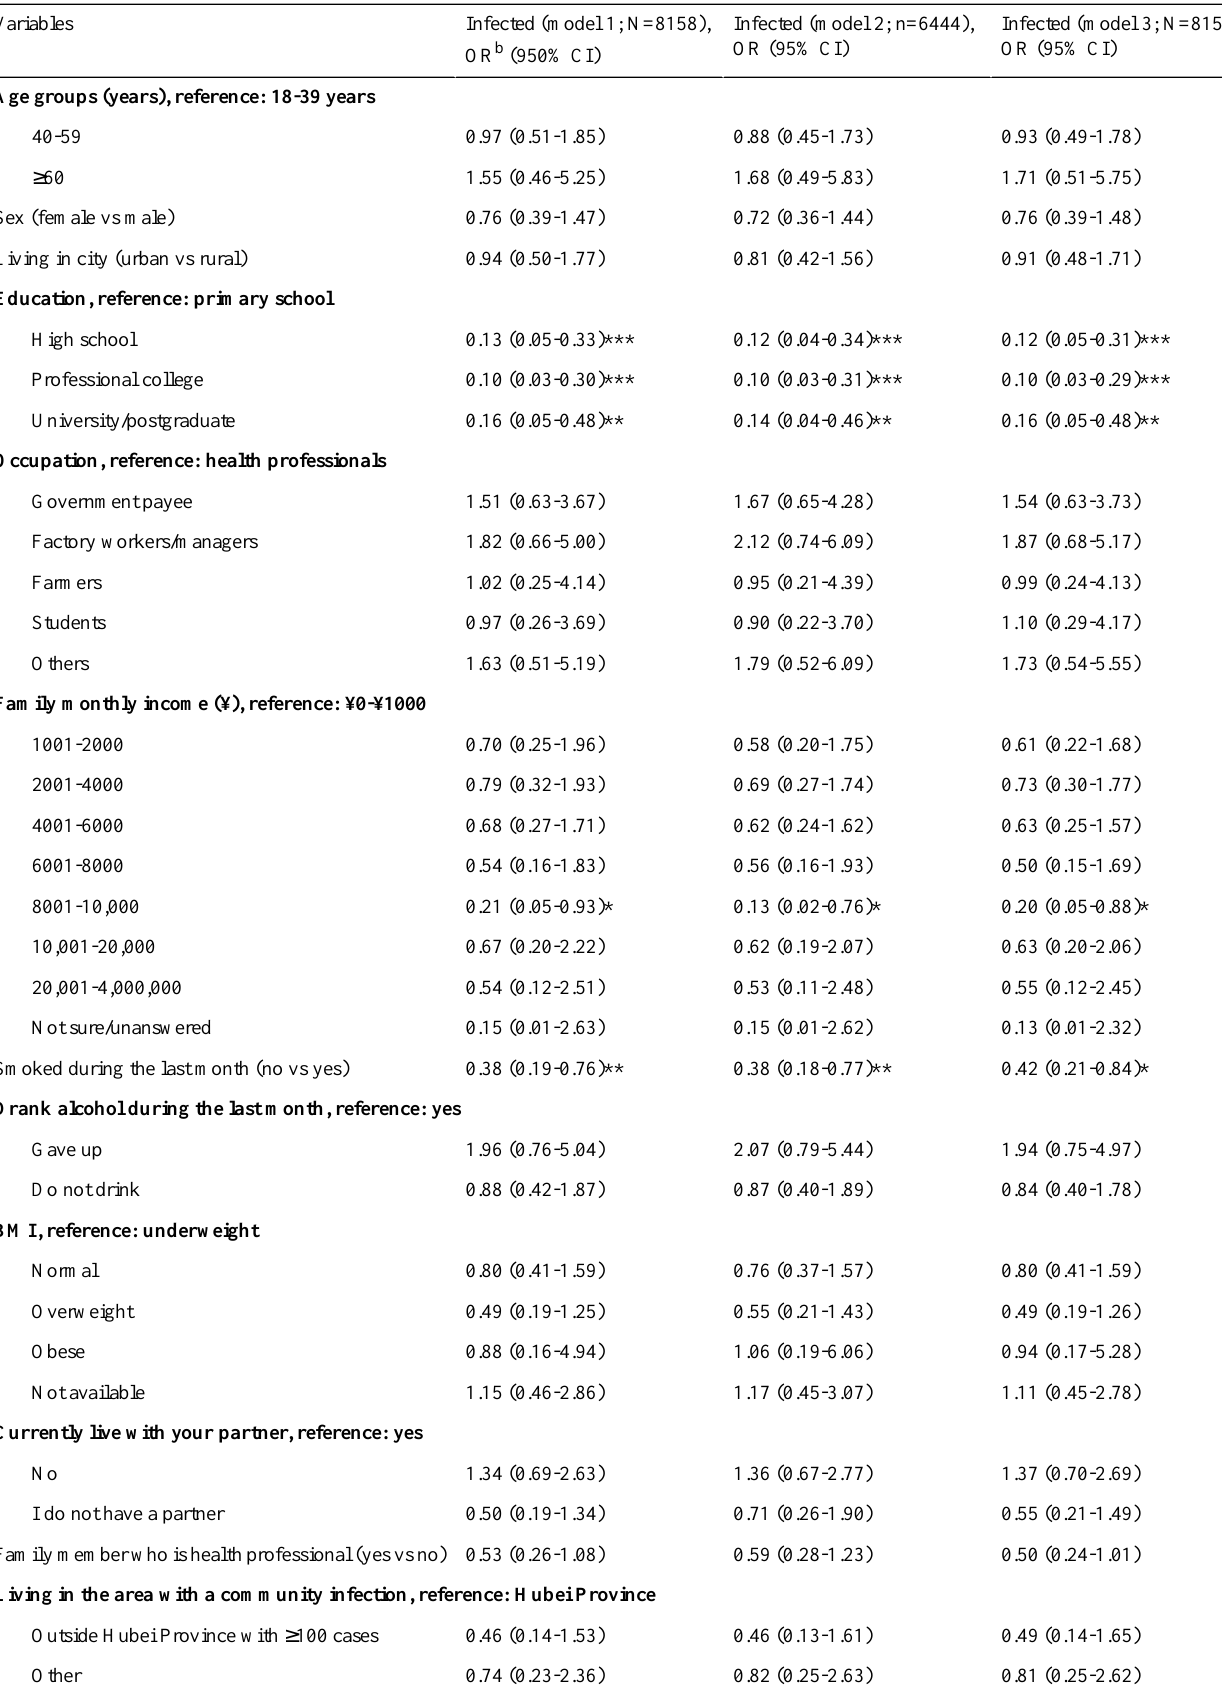
Table 6. Penalized logistic regression model results for COVID-19 infection and handwashing, coughing habits, social distancing, and mask wearing (models 1-3).